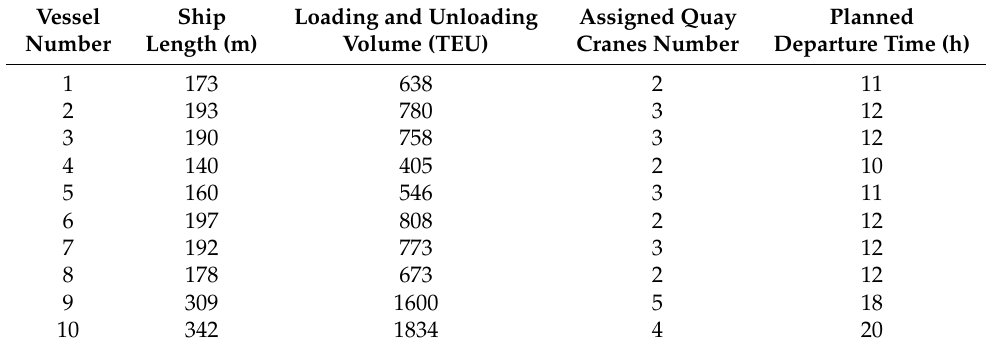
Table 2. Vessels information of a set of instances.